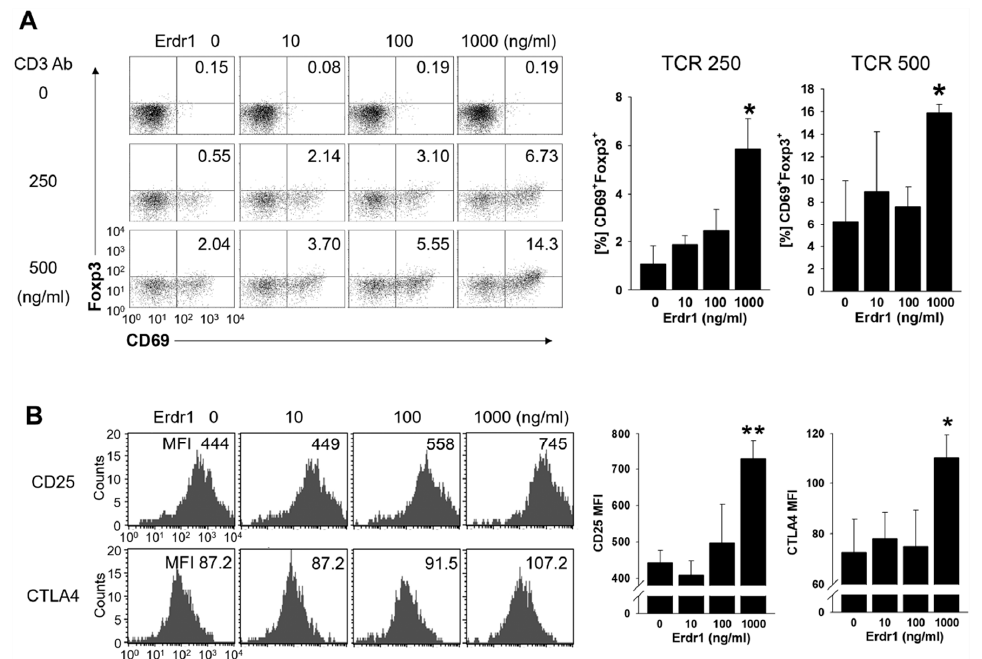
Figure 3. Erdr1 enhances the expression of activation markers in Treg cells. CD4 T cells were isolated from peripheral lymph nodes of DBA1 mice and cultivated with or without Erdr1 in the presence of T cell receptor (TCR) stimuli for 48 h. ( A ) CD4 T cells were cultured in anti-CD3 ε antibody-coated